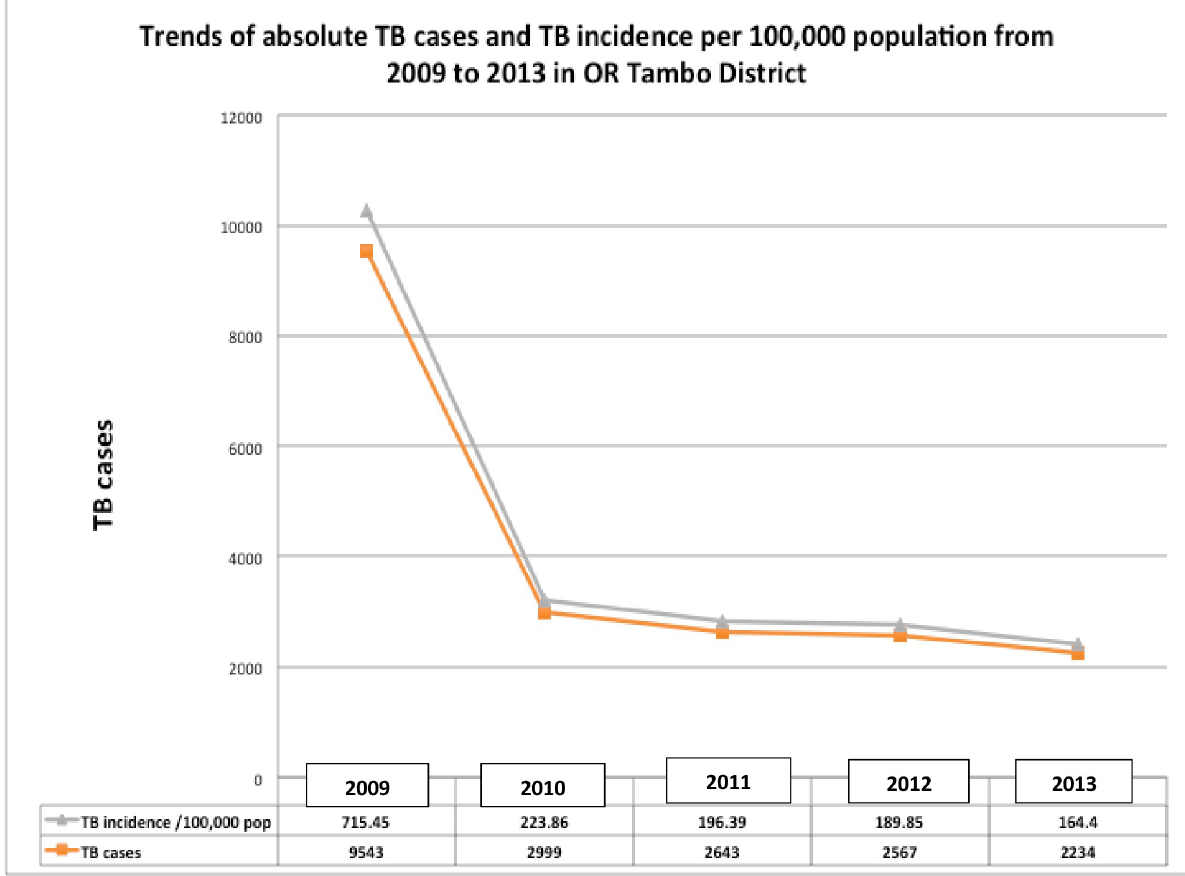
Fig 1. Trends of absolute TB cases and TB incidence per 100,000 population from 2009 to 2013 in OR Tambo district, Eastern Cape province– South Africa.